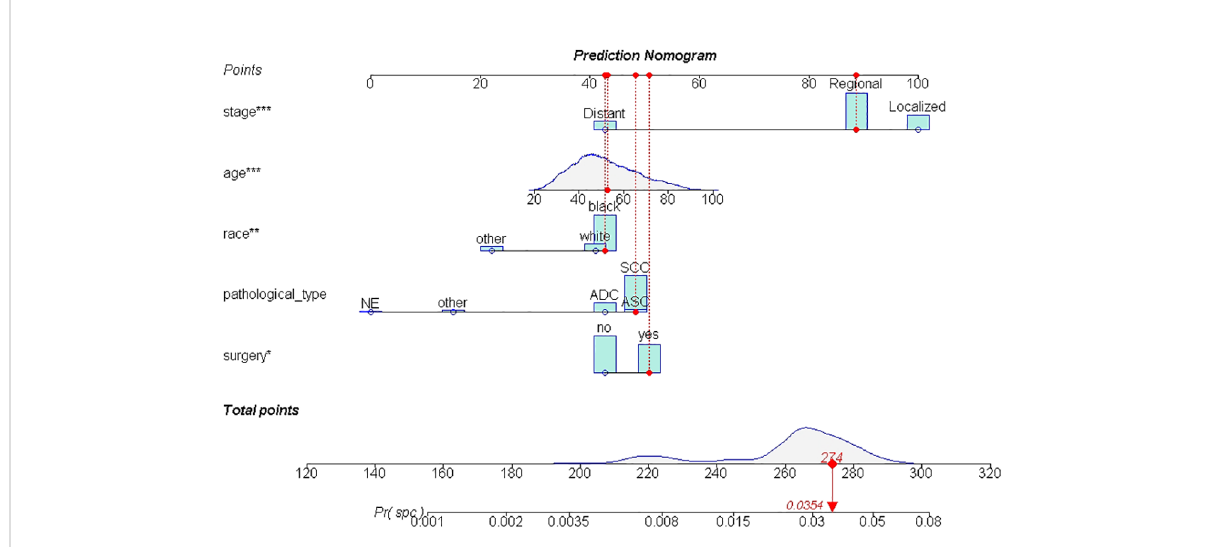
FIGURE 3 The nomogram of SPM risk prediction. *: p value <0.010; **: p value <0.005; ***: p value